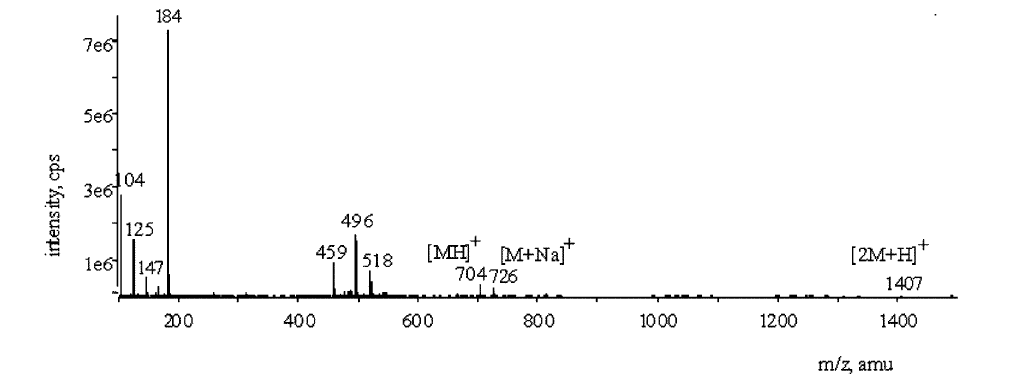
FIG. 3. Positive ion electrospray mass spectrum of the HPLC fraction of the hydroxyl-PAF analogue isolated from